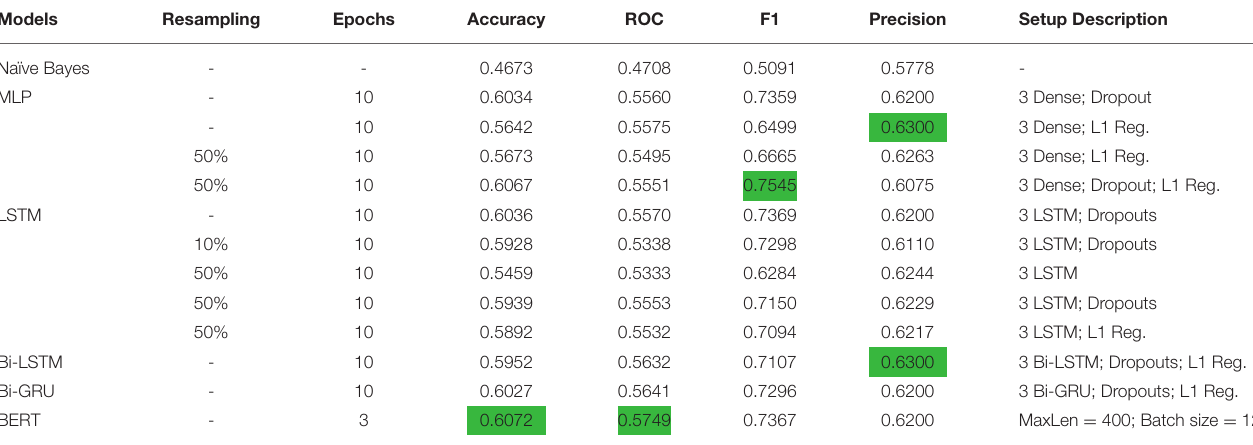
TABLE 5 | Classification performance on predicting FDV “hands-off” offense types (best results are highlighted in green).